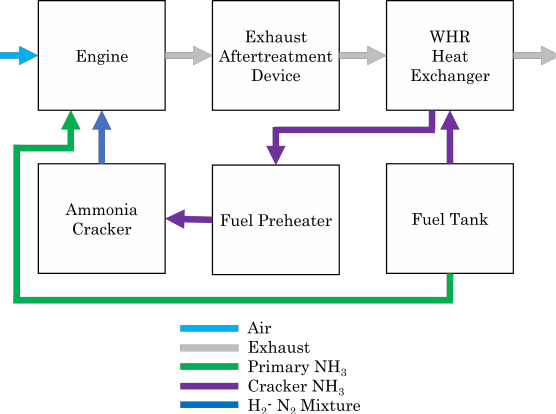
Figure 3. The layout of the proposed ammonia